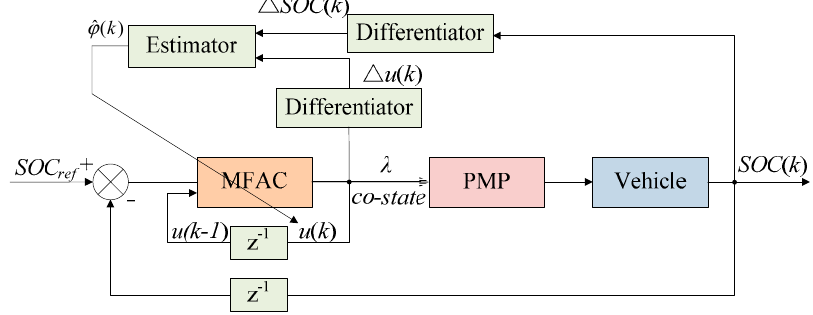
Figure 17. Model-free adaptive control (MFAC) scheme based on the PMP strategy.